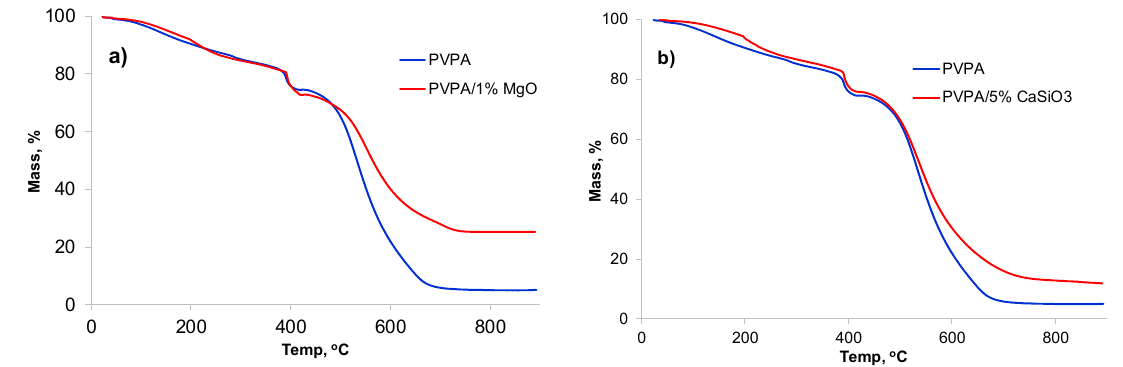
Figure 6. TGA curves under air of ( a ) PVPA, PVPA/1% MgO and ( b ) PVPA, PVPA/5% CaSiO 3.